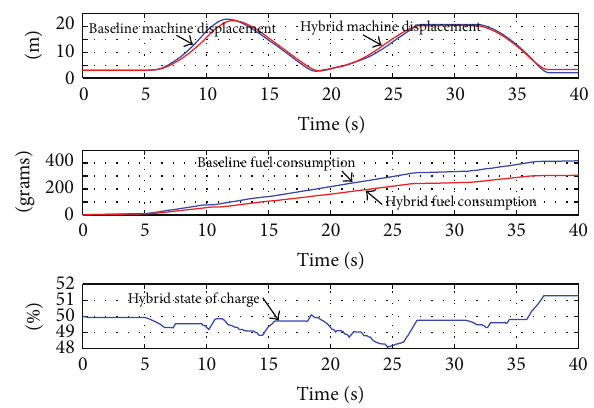
Figure 15: Moderate truck loading cycle.